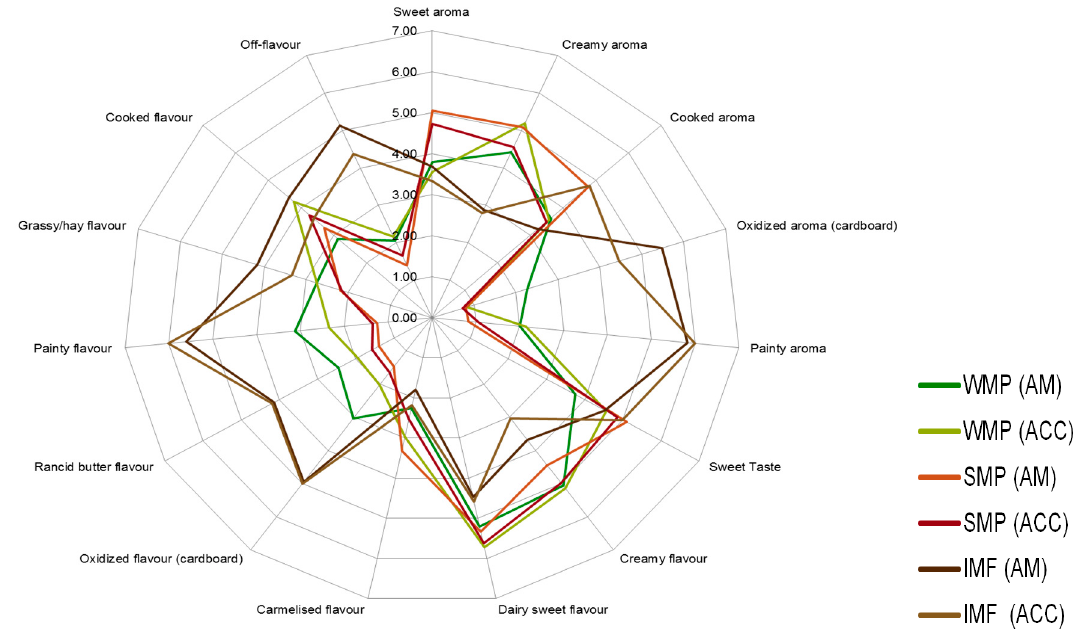
Figure 1. Radar plot illustrating the ranked descriptive analysis (RDA) scores for the sensory attributes evaluated at T16 for samples stored at 21 °C (AM) and 37 °C (ACC).